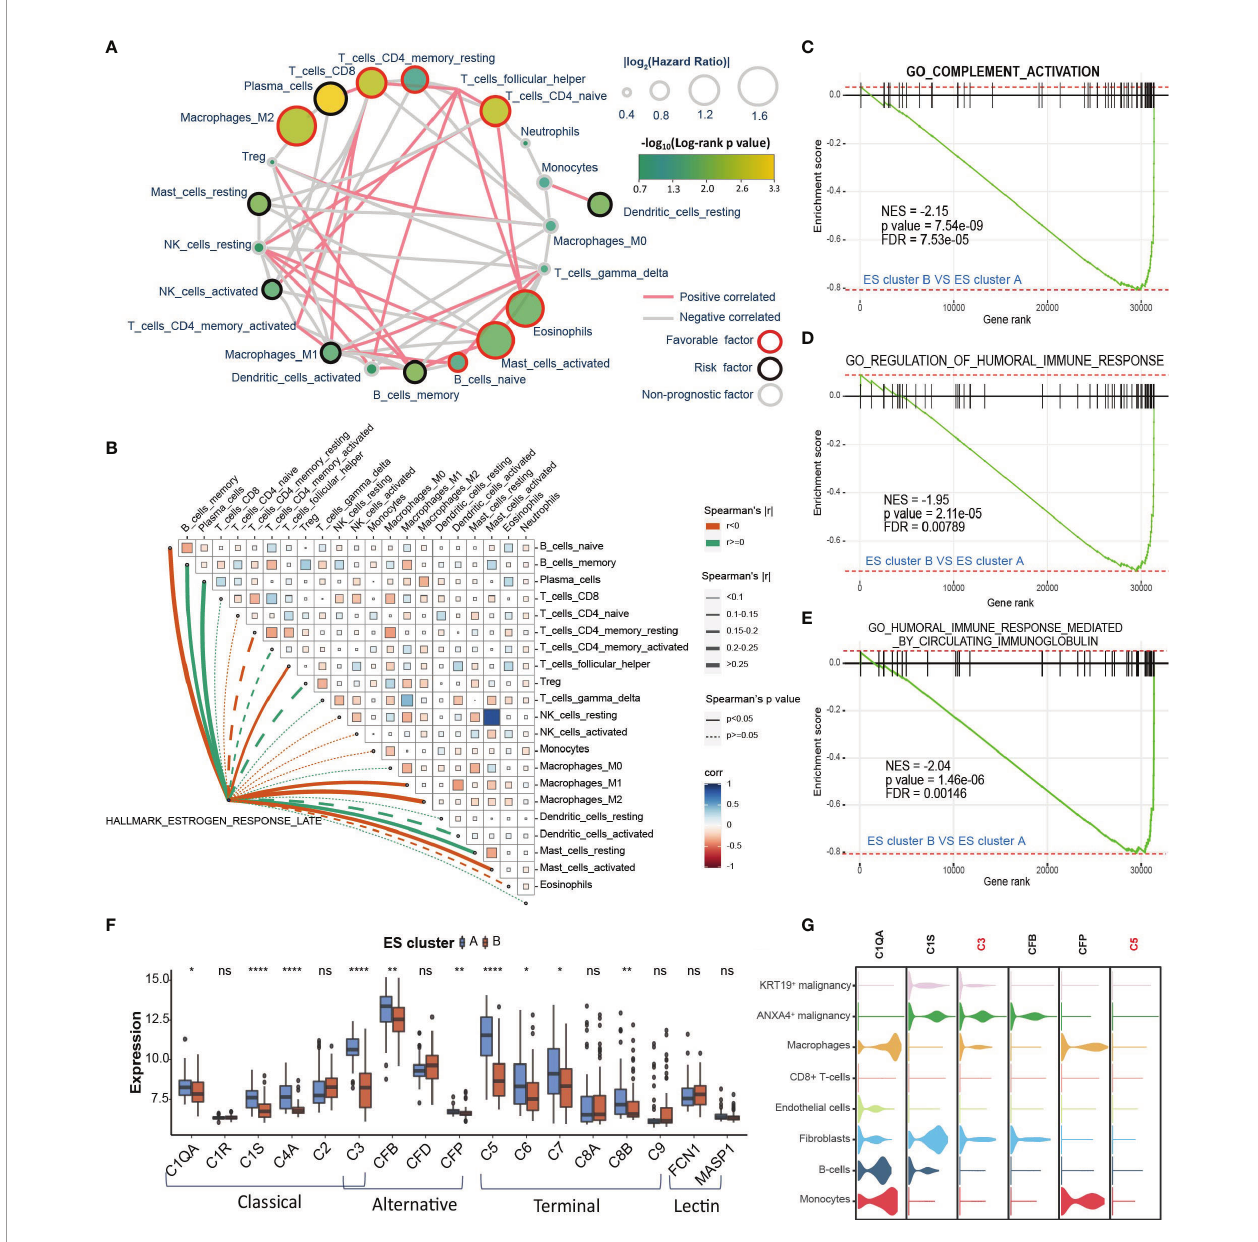
FIGURE 4 | The immune microenvironment differs between different ES clusters. (A) Landscape of immune cells in CCA. The size of the circle represents the | log2HazardRatio| of each immune cell. The color fi lling the circle represents the -log 10 (log-rank p value). The color of the border represents the prognostic value of the immune cells, and the color of the line between two immune cells represents the cell interaction estimated by Spearman correlation analysis. (B) Correlation analysis among the GSVA score of “ Estrogen response late ” and in fi ltration of different immune cells. (C – E) GSEA plot showing that complement activation and humoral immune response are downregulated in ES cluster B versus ES cluster A (F) The expression of complement of different complement activation pathways in ES clusters A and B. (G) The expression of speci fi c complements in different cell types of CCA tissues. Statistical p-value (*,P < 0.05; **,P < 0.01; ****,P < 0.0001). ns, not signi fi